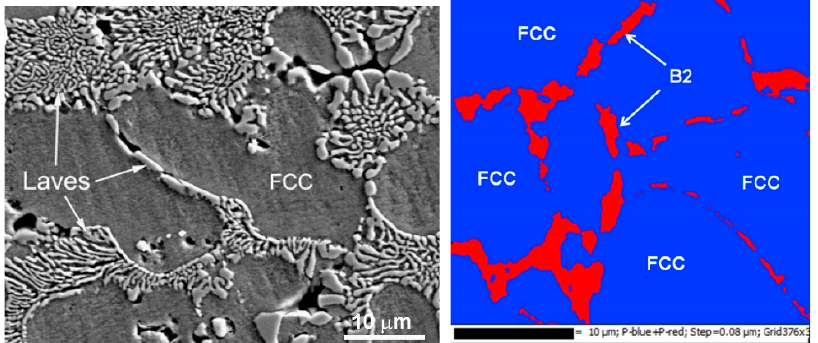
Figure 8. ( left ) SEM micrograph of the plasma cladded CoCrCuFeNiNb HEA coating. Micrograph is reprinted with permission from ref. [84]. Copyright 2014 Elsevier. ( right ) EBSD phase map of the Co 25 Cr 25 Cu 12.5 Ni 25 Al 12.5 (at.%) HEA. EBSD phase map shows that the Ni–Al-rich phase in the intergranular region is the B2 phase. Micrograph is reprinted with permission from ref. [94]. Copyright 2014 Elsevier.